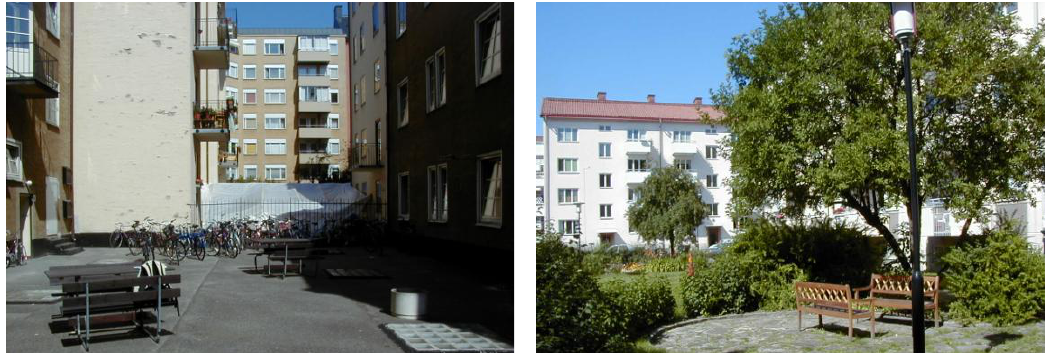
Figure 1. Examples of ―quiet‖ courtyards in the study with low (left) and high environmental physical quality